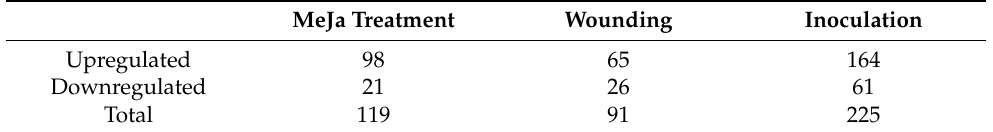
Table 11. Comparison of transcriptional responses of two-year-old MeJa-treated Scots pine trees to and one-year-old wounded or inoculated (with H. annosum ) Scots pine trees. MeJa Treatment Wounding Inoculation Upregulated 164